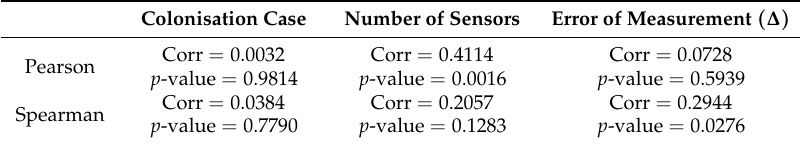
Table 13. Correlation between metrics for ρ and inputs of scenarii.